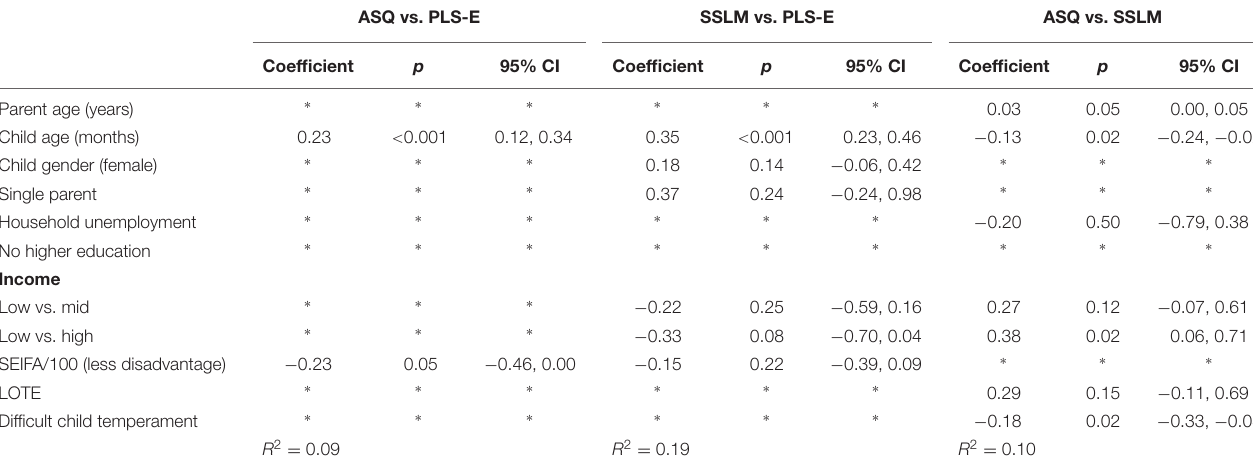
TABLE 5 | Adjusted analysis for Language for Learning difference scores and socio-demographic factors. ASQ vs. PLS-E